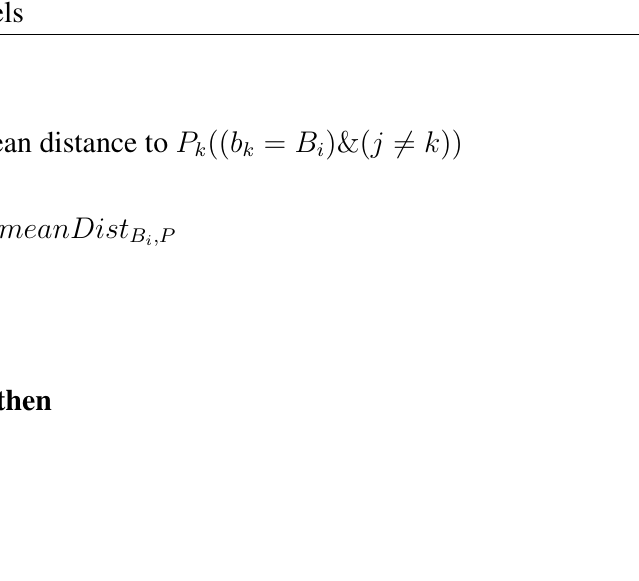
Algorithm 1 Removal of mislabeled